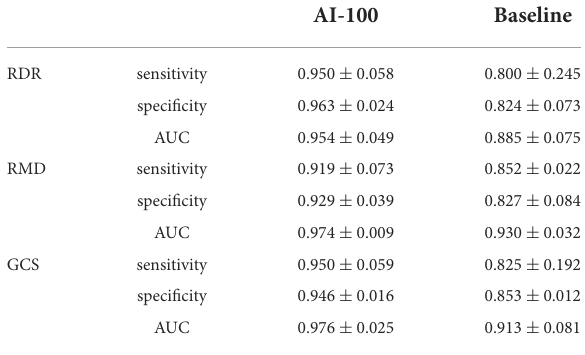
TABLE 6 Mean and standard deviation of performance values for AI-100 and the baseline model,